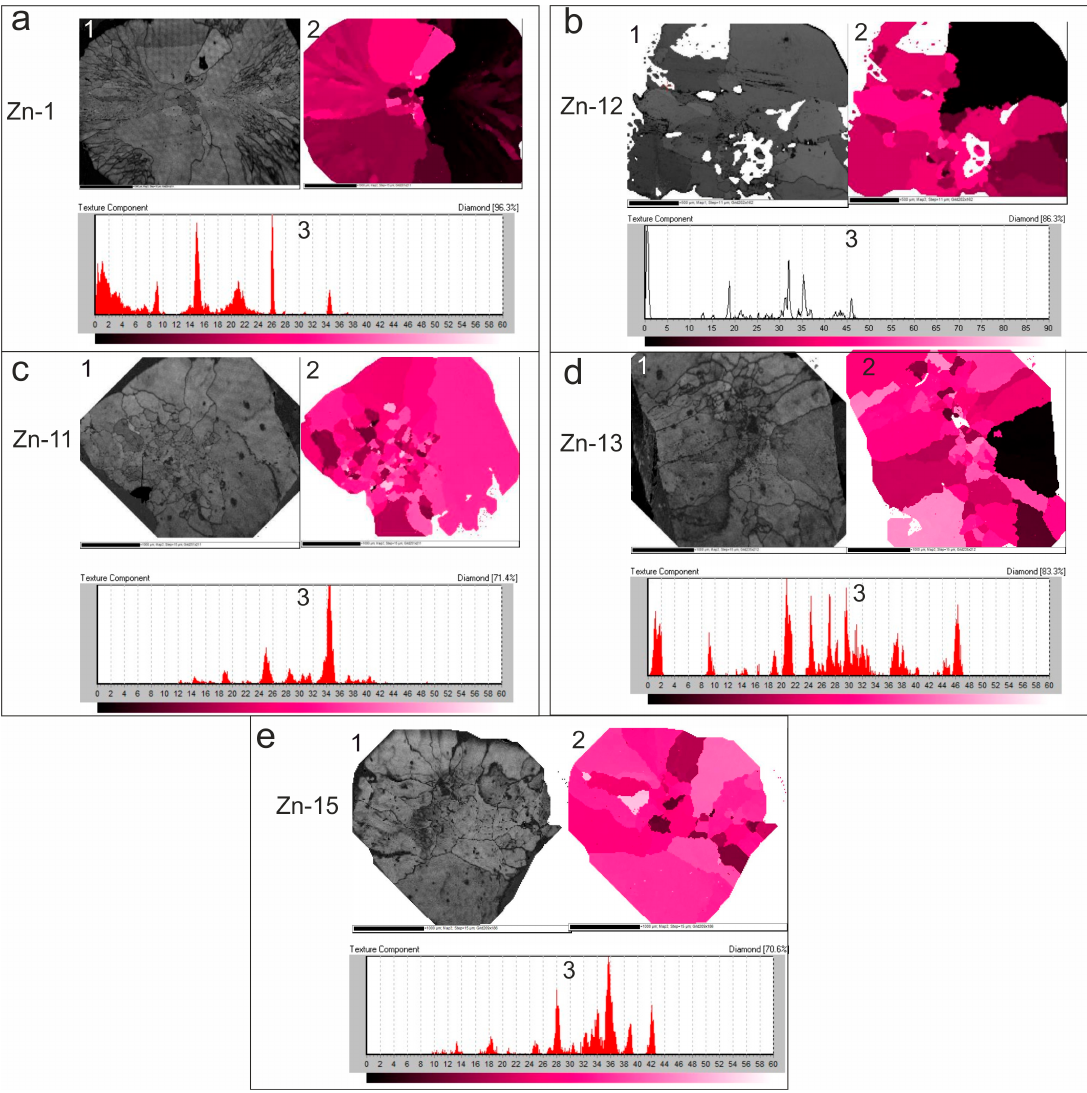
Figure 5. Mosaic-block internal structures of diamonds consisting of subgrains (subindividuals) misorientated relative to each other (1—reflected light, 2—EBSD image, 3—misorientation degrees) ( a ) Sample Zn-1; ( b ) Sample Zn-12; ( c ) Sample Zn-11; ( d ) Sample Zn-13; ( e ) Sample Zn-15.